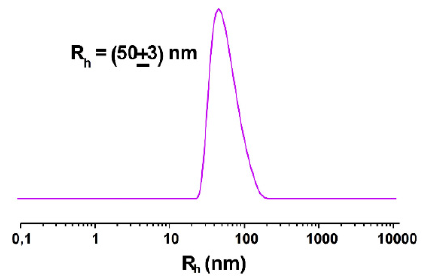
Figure 5. Hydrodynamic radius distribution function obtained through DLS measurements for 1 mM extruded NOTA-OL/POPC 10:90 liposomes.